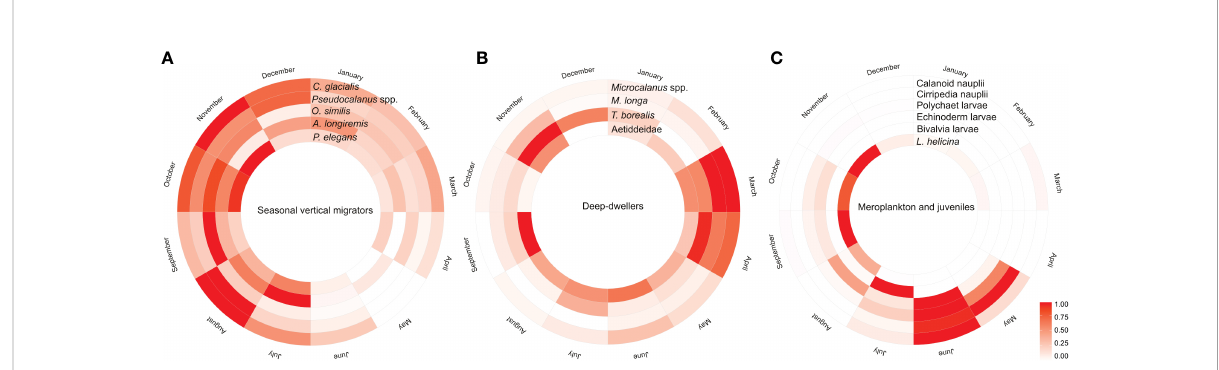
FIGURE 8 Circular heatmap summarizing the seasonal changes in relative abundance of (A) seasonal vertical migrators, (B) deep-dwellers, and (C) seasonal visitors occurring in high numbers during shorter periods such as larvae of benthic taxa (meroplankton) and holoplankton (copepod nauplii and juveniles of Limacina spp.).Color scale is a relative scale based on abundance (ind m − 3 ), i.e., lowest abundance of each taxa = 0, the highest = 1, and all other values are linearly scaled accordingly so that dark color tones mark the month with highest abundance and lighter colors and white mark the month with lowest